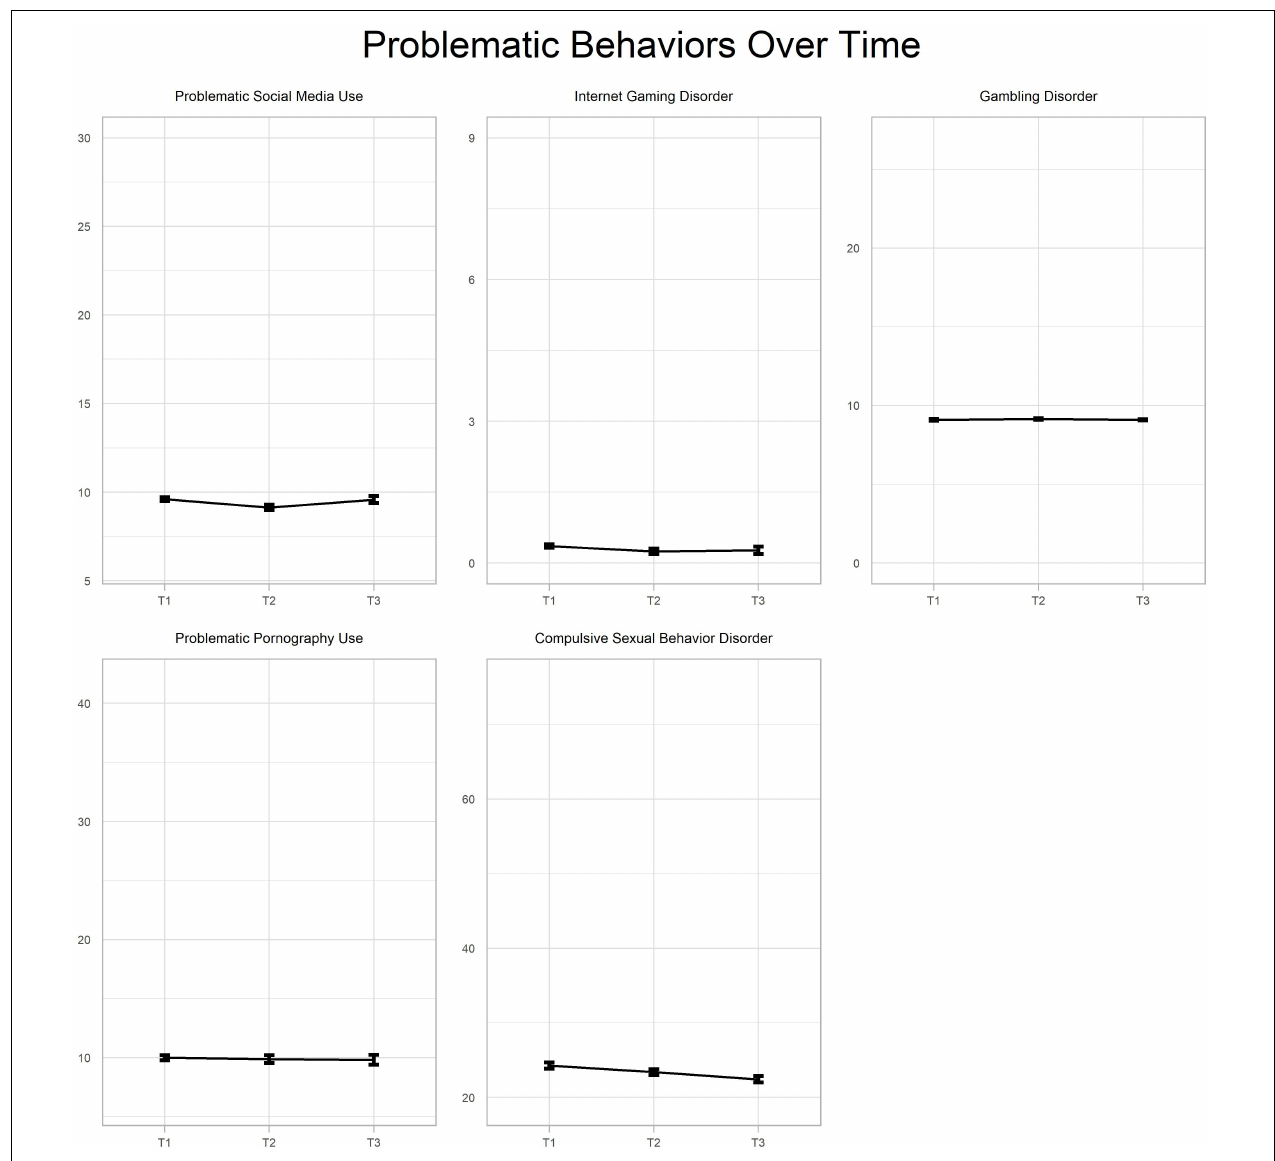
FIGURE 1 | Visual representation of the problematic behaviors over time. X-axis values should be interpreted as follows: T1 = May 2020, T2 = July–August 2020, T3 = January 2021.